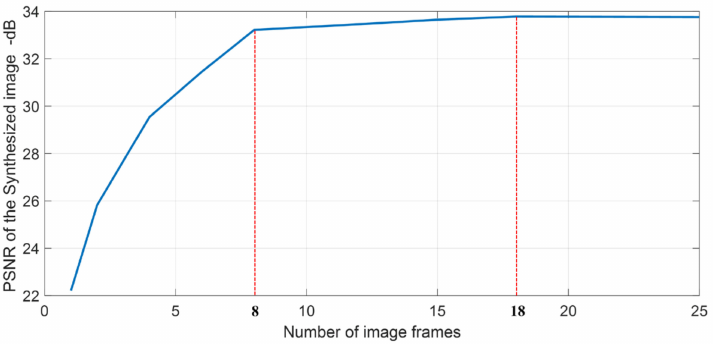
Figure 11. The relationship of the synthesized image’s PSNR and the number of image